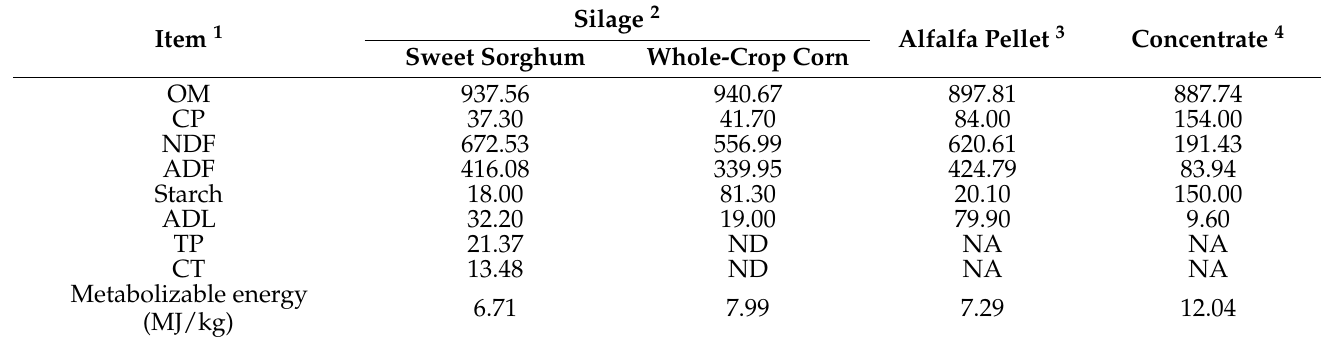
Table 1. Chemical composition of the experimental diets (g/kg on dry matter